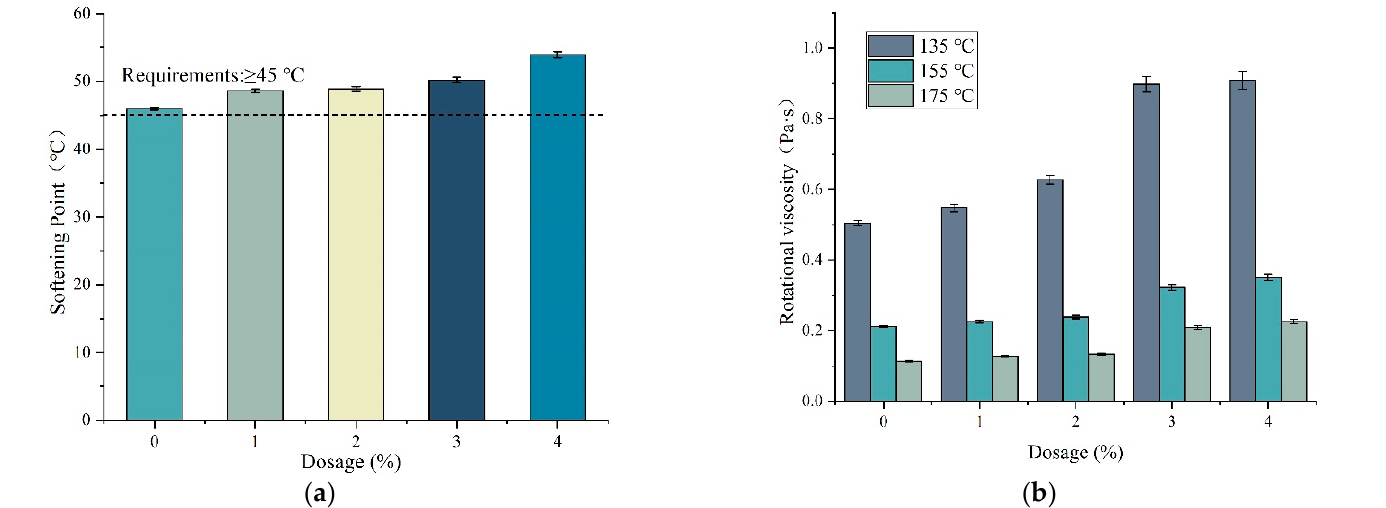
Figure 4. Physical properties of DM-modified asphalt. ( a ) Softening point and ( b ) rotational viscosity (135 °C, 155 °C and 175 °C).